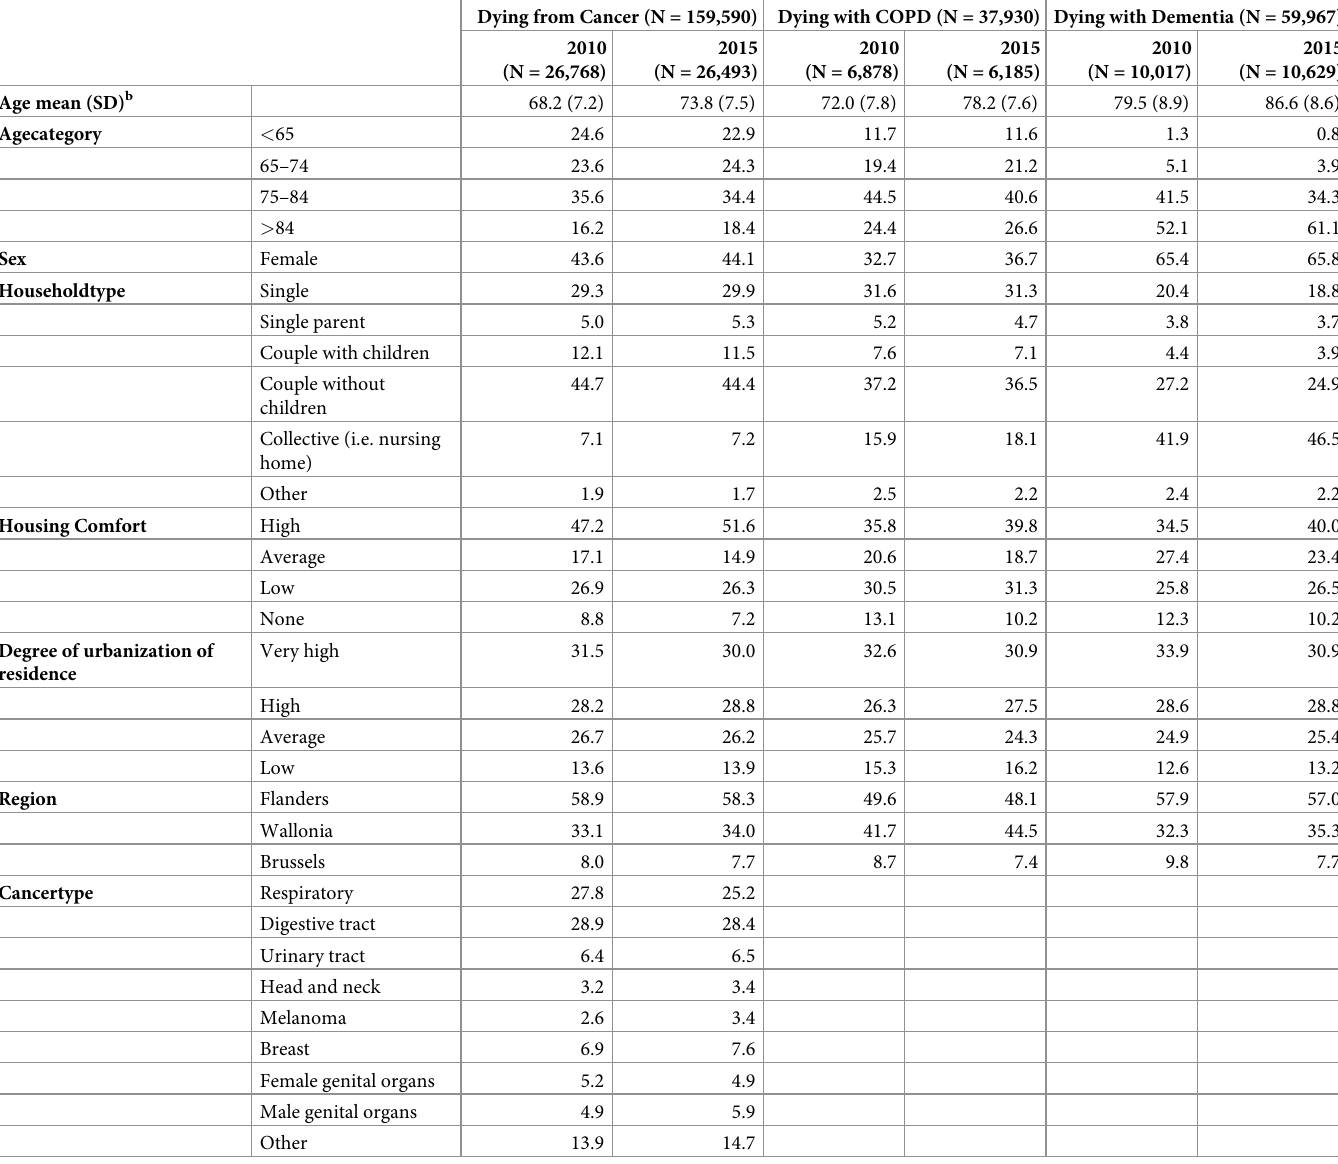
Table 1. Summarized population description of all people who died from cancer, with COPD or with dementia in Belgium from 2010 until 2015 a . Dying from Cancer (N = 159,590) Dying with COPD (N = 37,930) Dying with Dementia (N = 59,967)